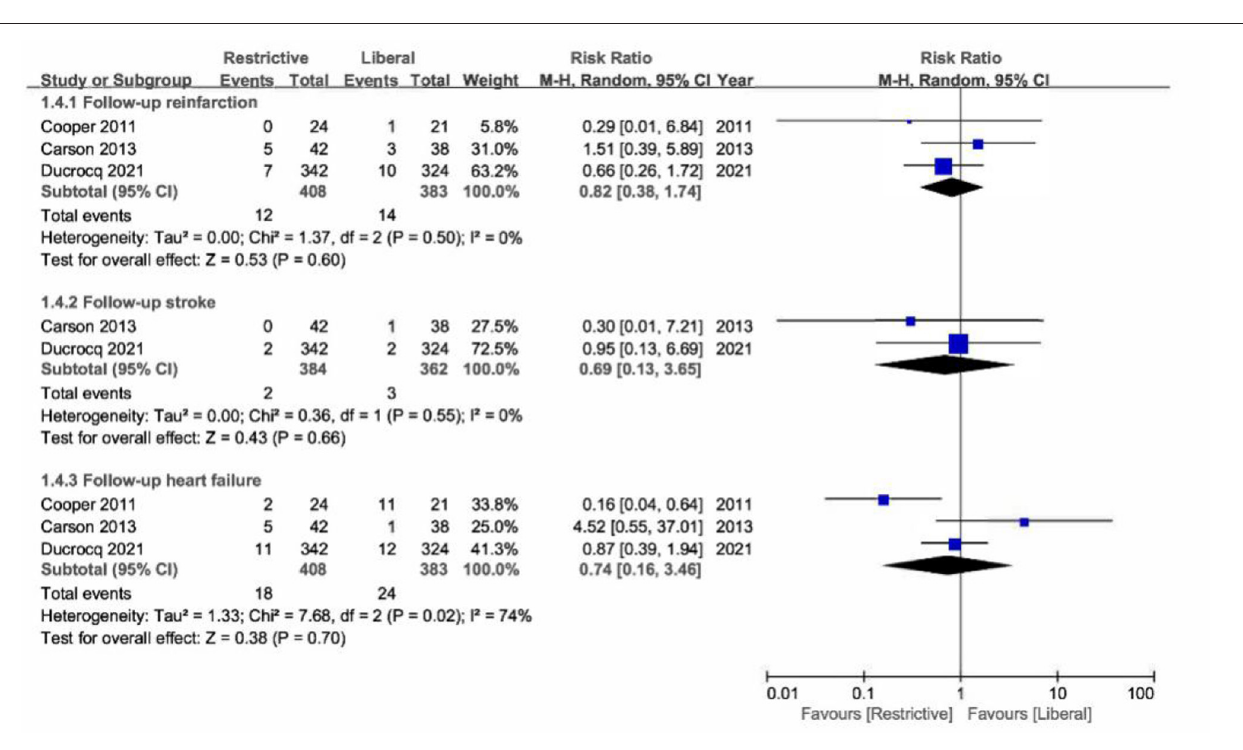
FIGURE 3 | Forest plot for the association between blood transfusion strategies with secondary